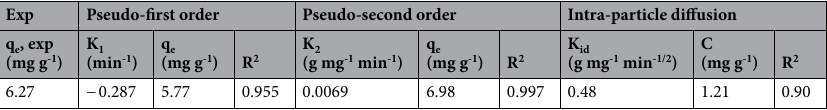
Table 7. Adsorption kinetic parameters of MB on PVA/CMC/TUR